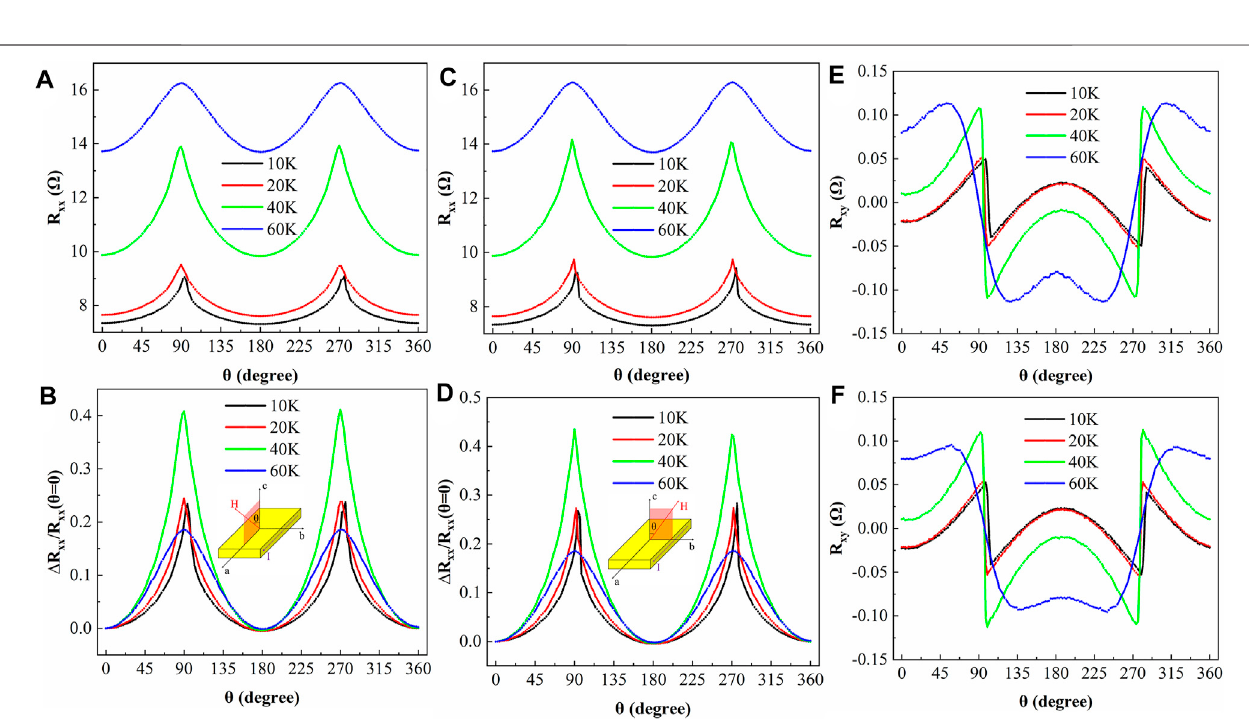
FIGURE3| Measured angle-dependent magnetoresistance withthemagnetic fi eldrotates intheac-plane (A,B) and bc-plane (C,D) at 10,20,40,60K. Theinsets in (B,D) show the schematic ofthe corresponding measurementcon fi guration. The measured angle-dependent Hall resistance with the magnetic fi eld rotates in the ac- plane (E) and bc-plane (F)